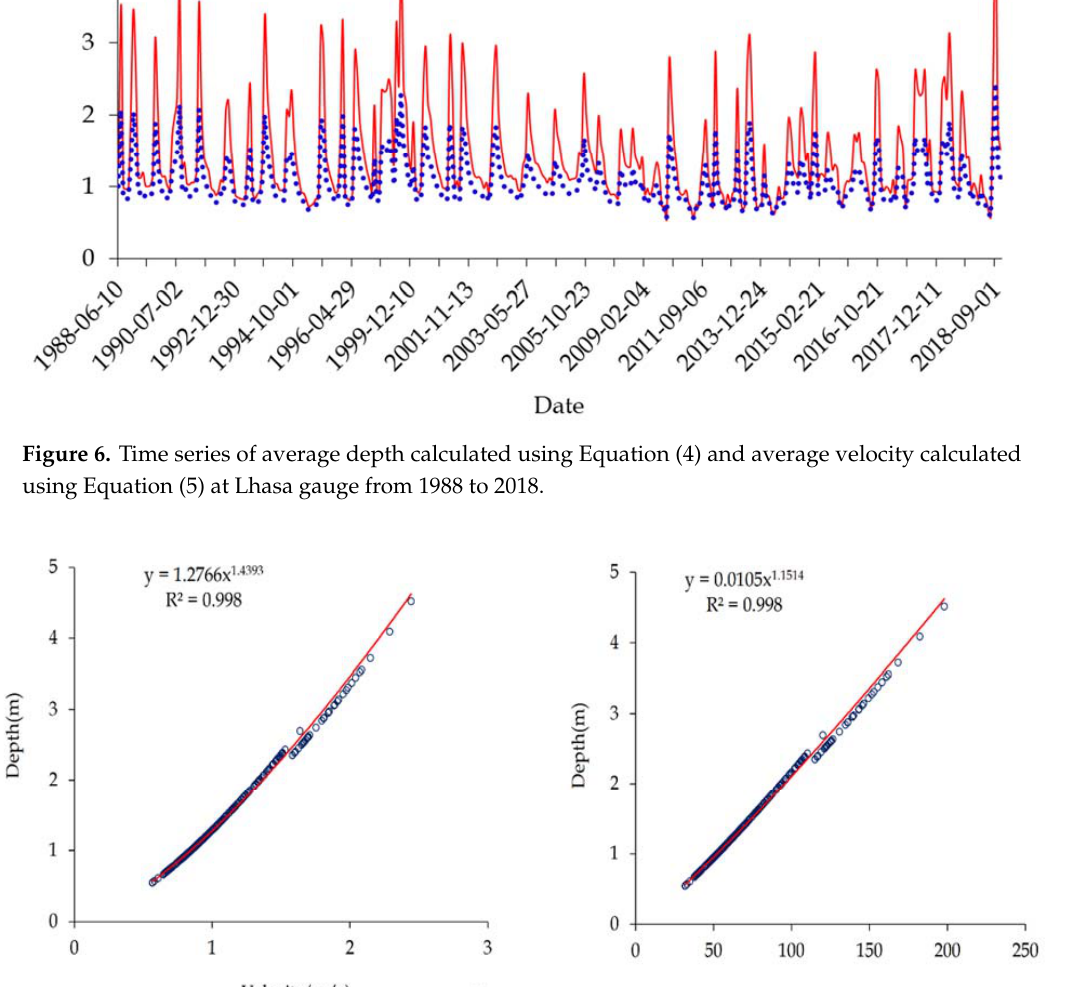
Figure 7. (a) Scatterplots of average depth (estimated using Equation (4)) versus average velocity (estimated using Equation (5)); (b) scatterplots of average depth versus effective width (estimated using Equation (2)) at Lhasa gauging station during the study period 1988–2018. Both plots show strong relationships between depth and average effective width or velocity, with two distinct curves for lower values and moderate to high values.